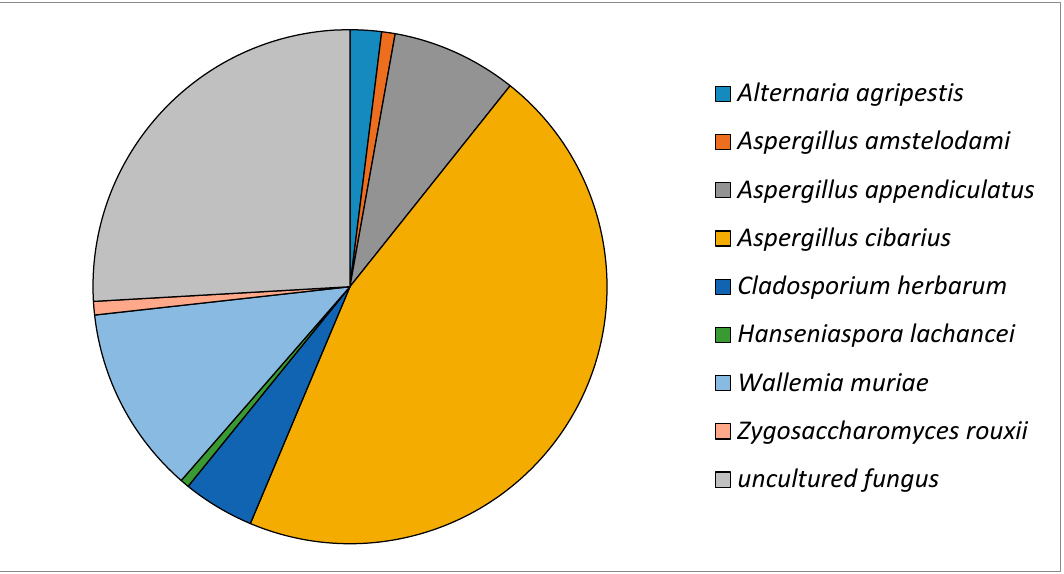
Figure 1. Relative presence (%) of fungal species identified in golden flaxseed via high-performance sequencing of the ITS intergenic region.